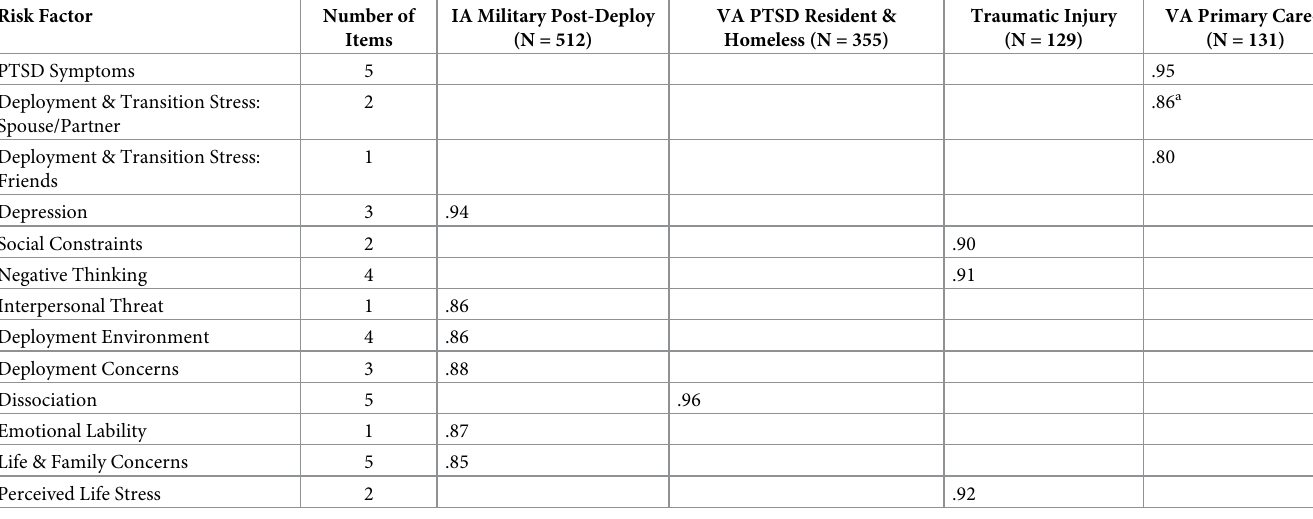
Table 3. Number of Items in brief measures and correlations between brief and full